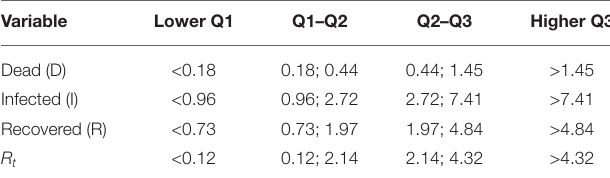
TABLE 1 | Summary of performance measures by quartile based on RMSE